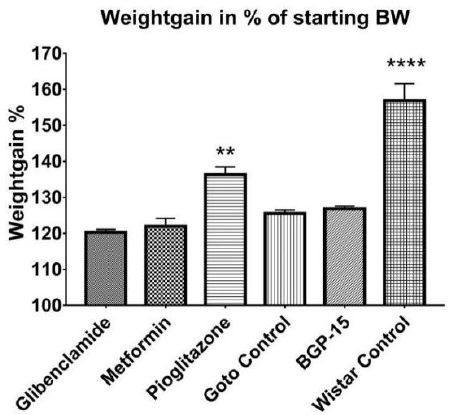
Figure 3. Weight gain percentages of the animal groups: mean weight of animals of each group at the end of the experiment expressed in percentages of their initial mean weight. Data is presented as group mean ± standard error of the mean (SEM); n = 6 animals in each group. ** p < 0.01 compared to all other groups; **** p < 0.0001 compared to all other groups. Statistical analysis was done using GraphPad Prism: after estimation of Gaussian distribution with Shapiro-Wilk normality test data was either analysed with one-way analysis of variance (ANOVA) or non-parametric Kruskal-Wallis test.